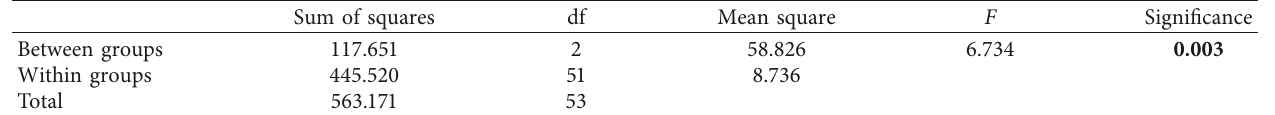
Table 2: One-way ANOVA for the uptake scores.